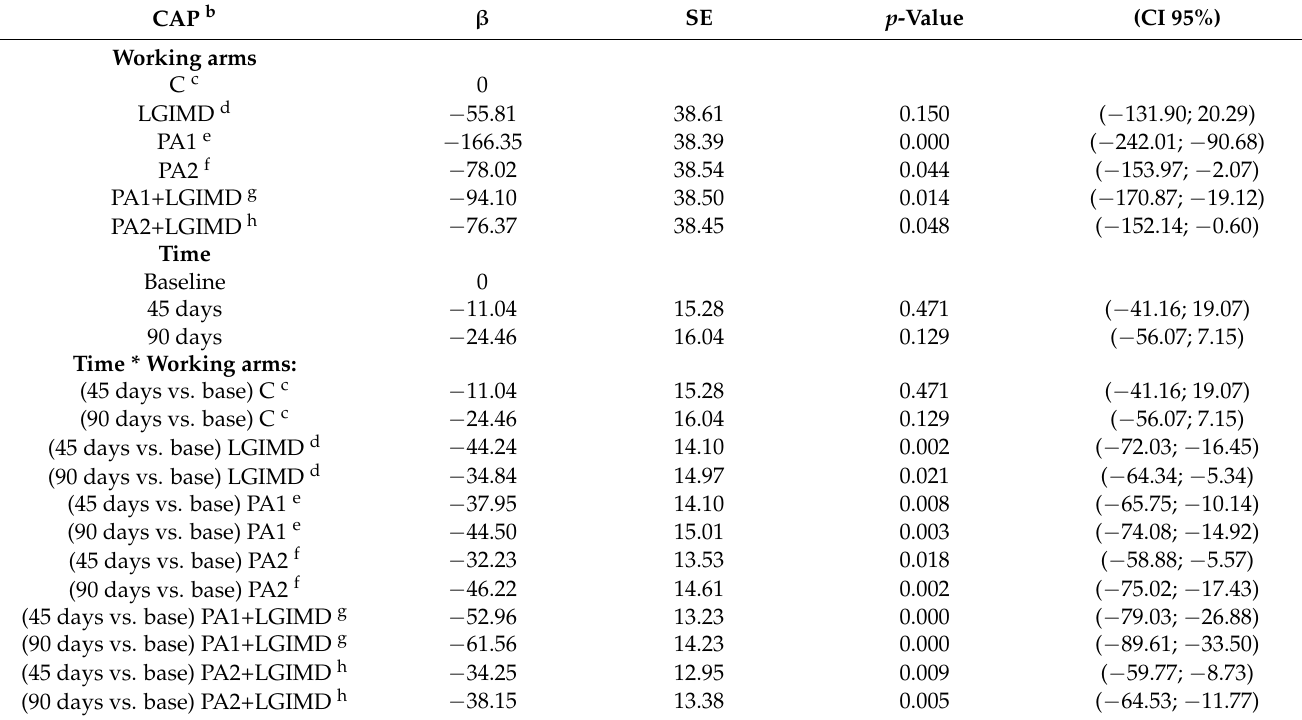
Table 6. Repeated Measures Analysis of Variance. Effect of Treatments on NAFLD a Scores (assessed by CAPb value) by Intervention Arms and Time and Contrast between Intervention and Time. NutriAtt Trial, Castellana Grotte,